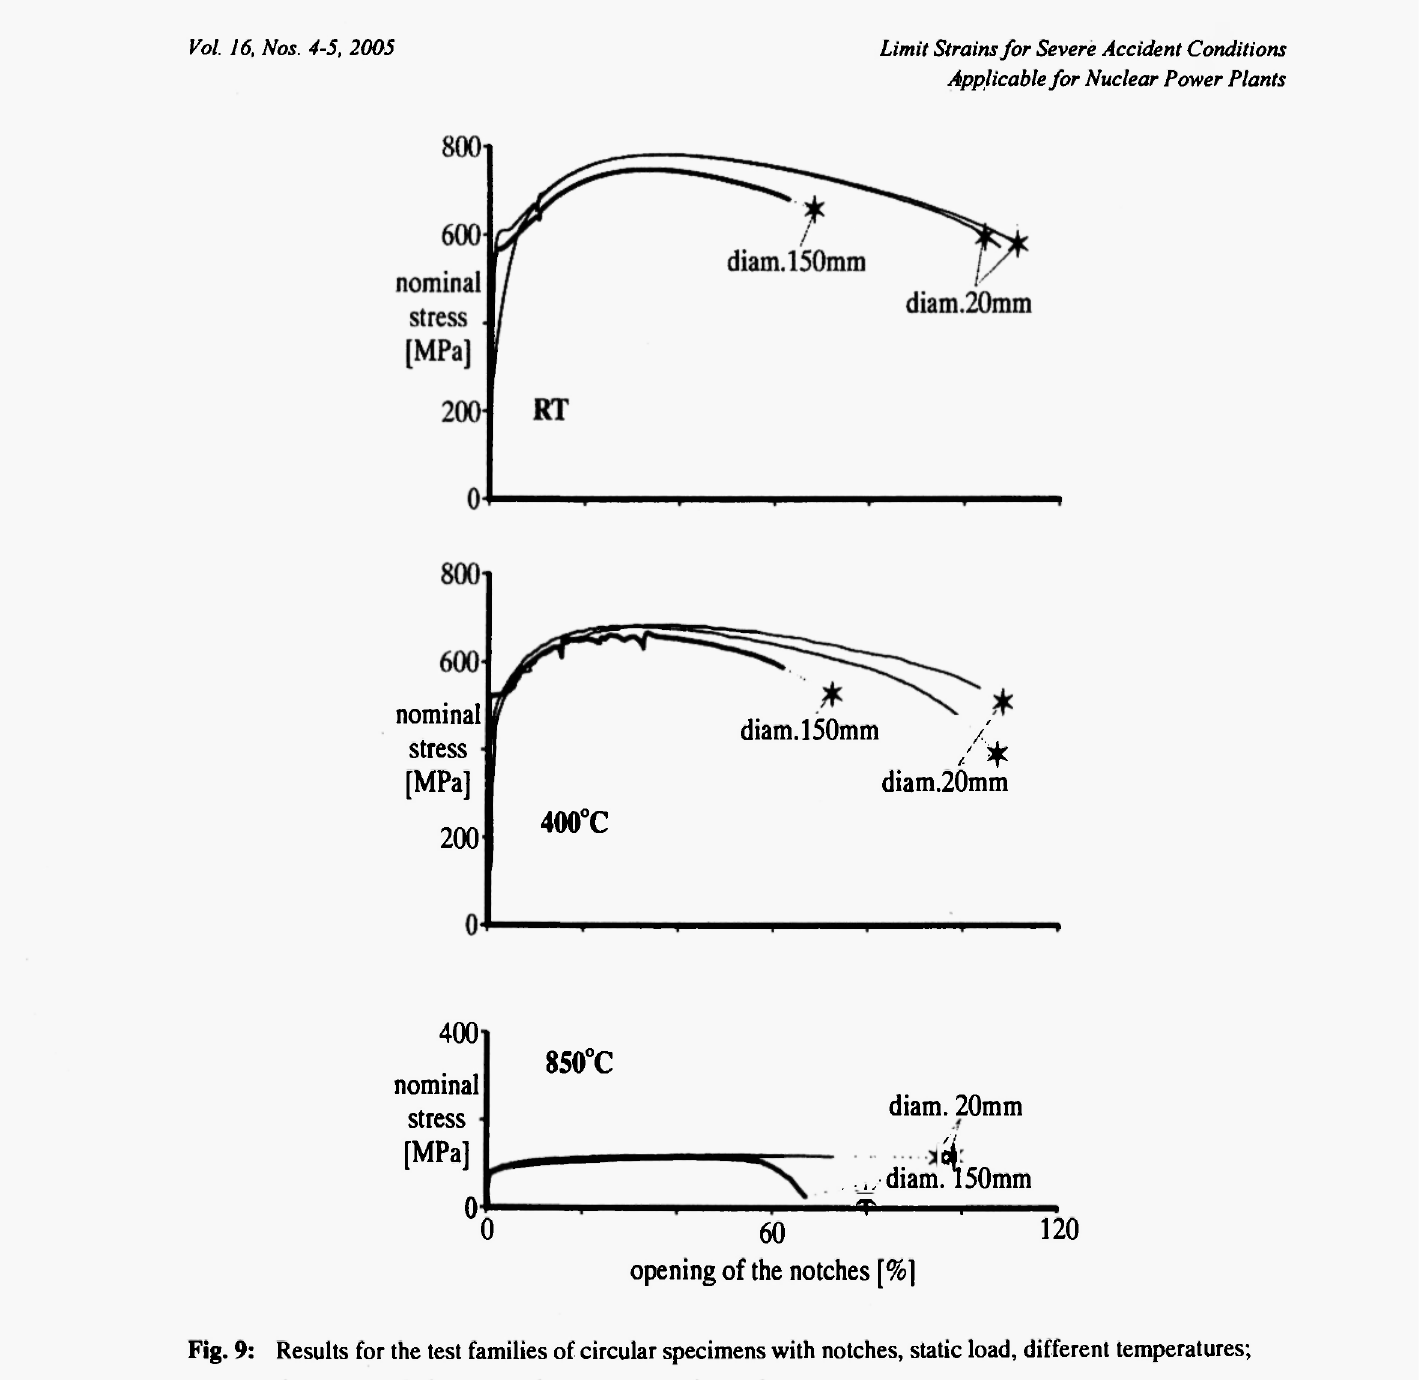
Fig. 9: Results for the test families of circular specimens with notches, static load, different temperatures; the stars mark the states where macroscopic cracks